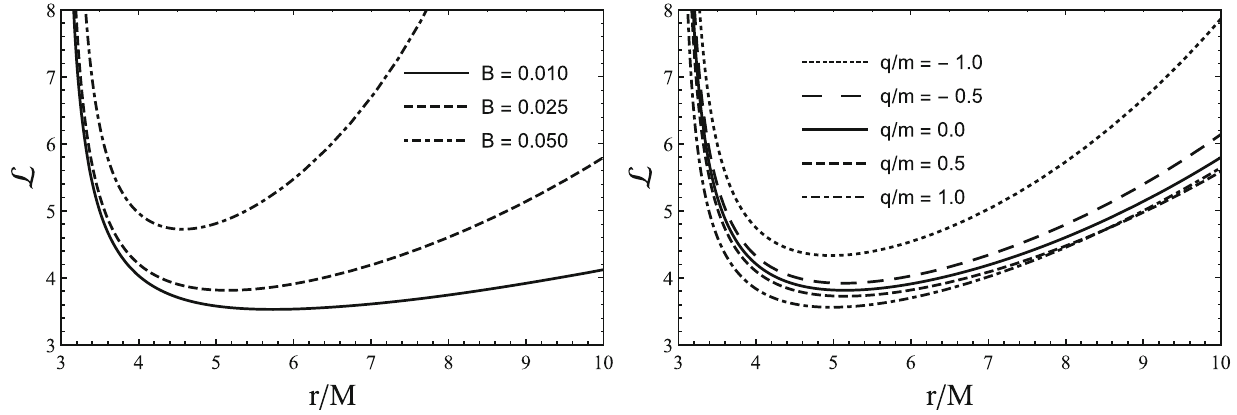
Fig. 4 Plot showing the radial dependence of the angular momentum as a function of r / M in the equatorial plane (i.e. θ = π/ 2). Left panel: L is plotted for various combinations of magnetic field parameter B for